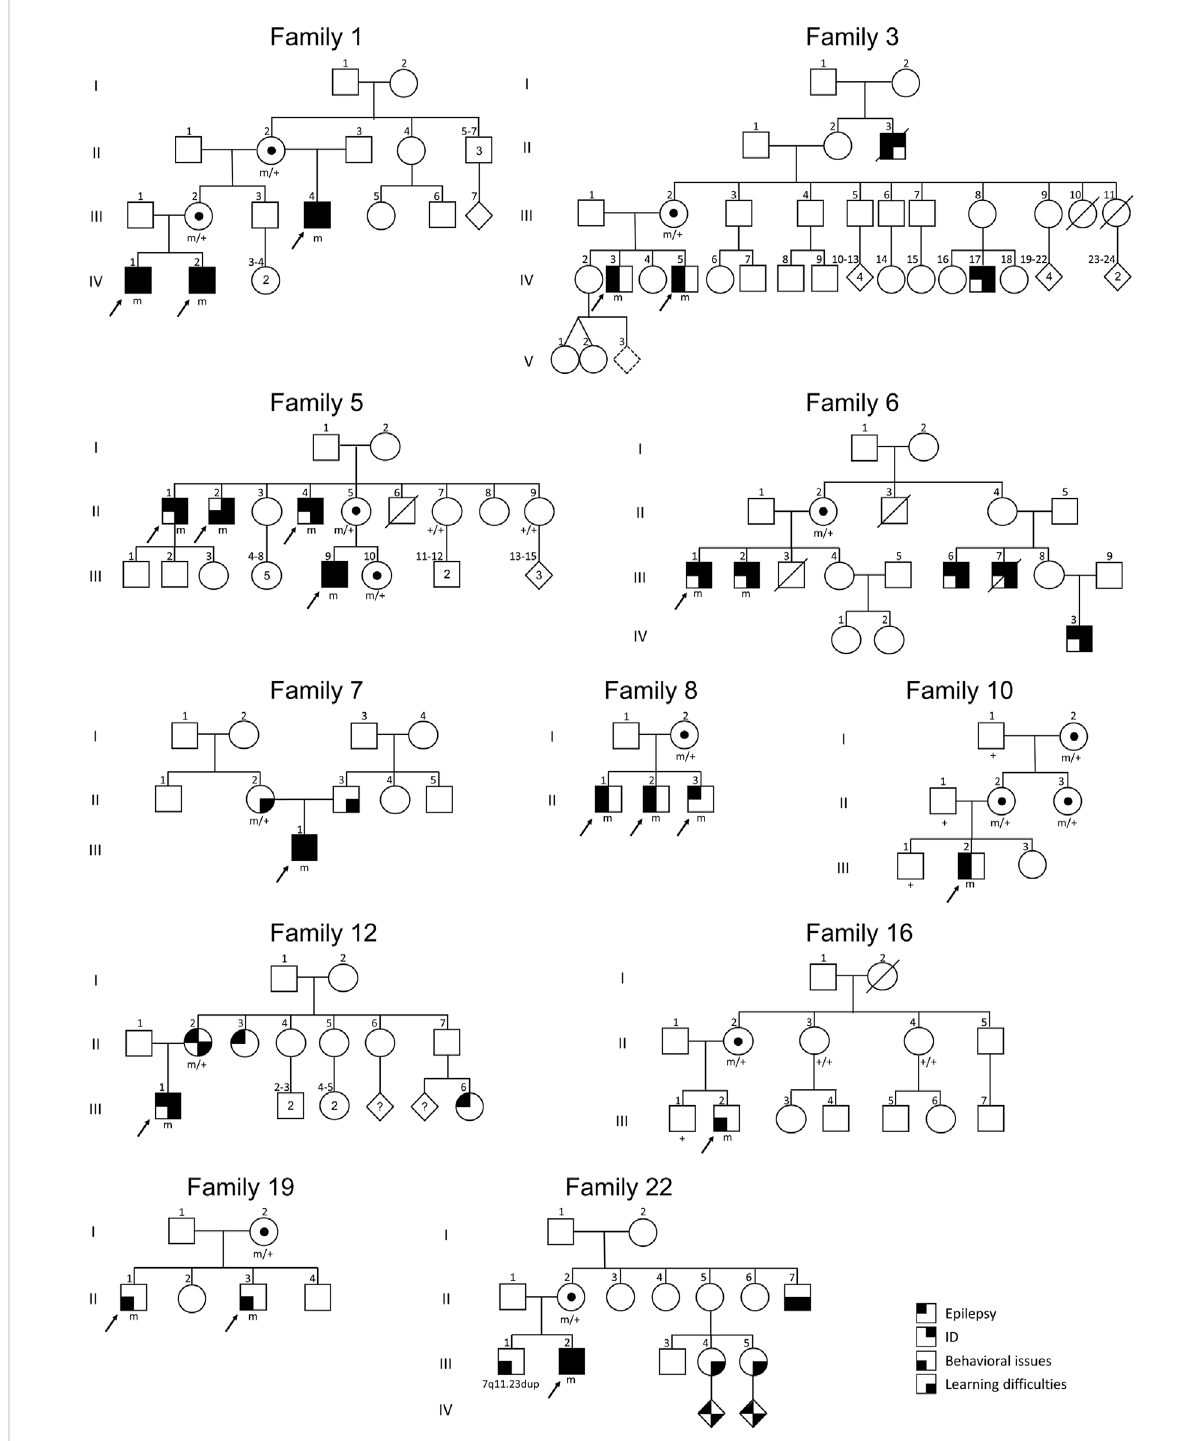
FIGURE 3 Pedigreesofthe SYN1 familialcasesofourcohort.Blackarrowsindicatetheindexcasesinitiallyreferredtothegeneticcenter.Individualswithin the same family tree are variably affected, pointing to the existence of incomplete penetrance and clinical heterogeneity.